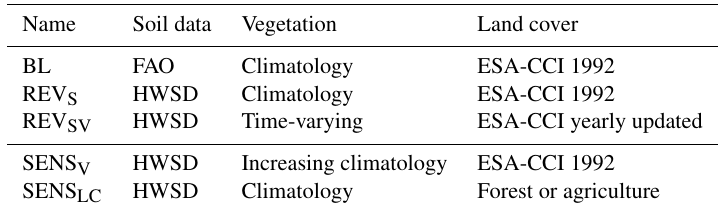
Table 1. Overview of experiments.